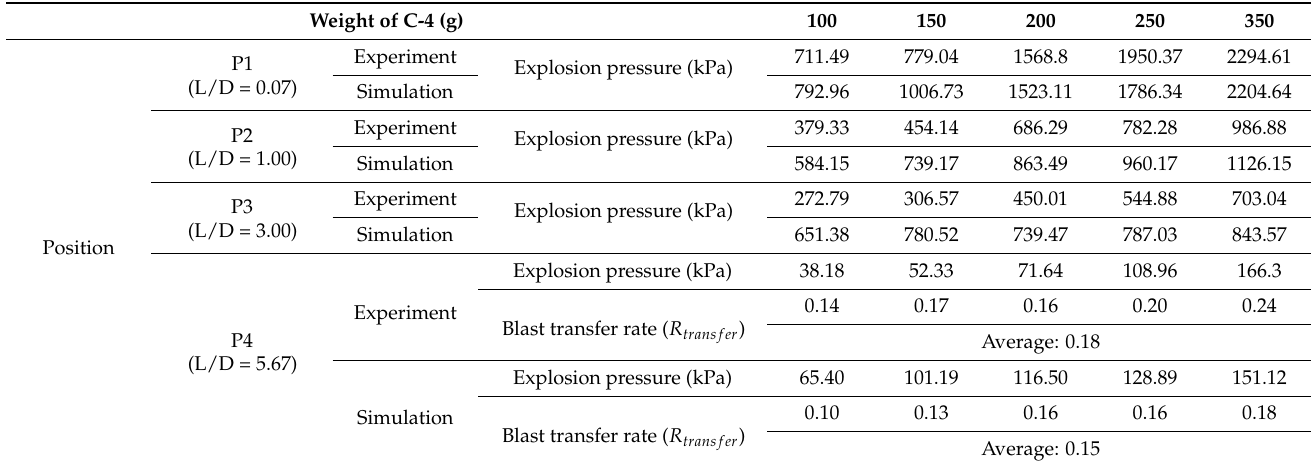
Table 3. Comparison of experiment and numerical results of steel tunnel with double-pressure relief orifice plate. Weight of C-4 (g) 100 150 200 350 Experiment P1 (L/D = 0.07)